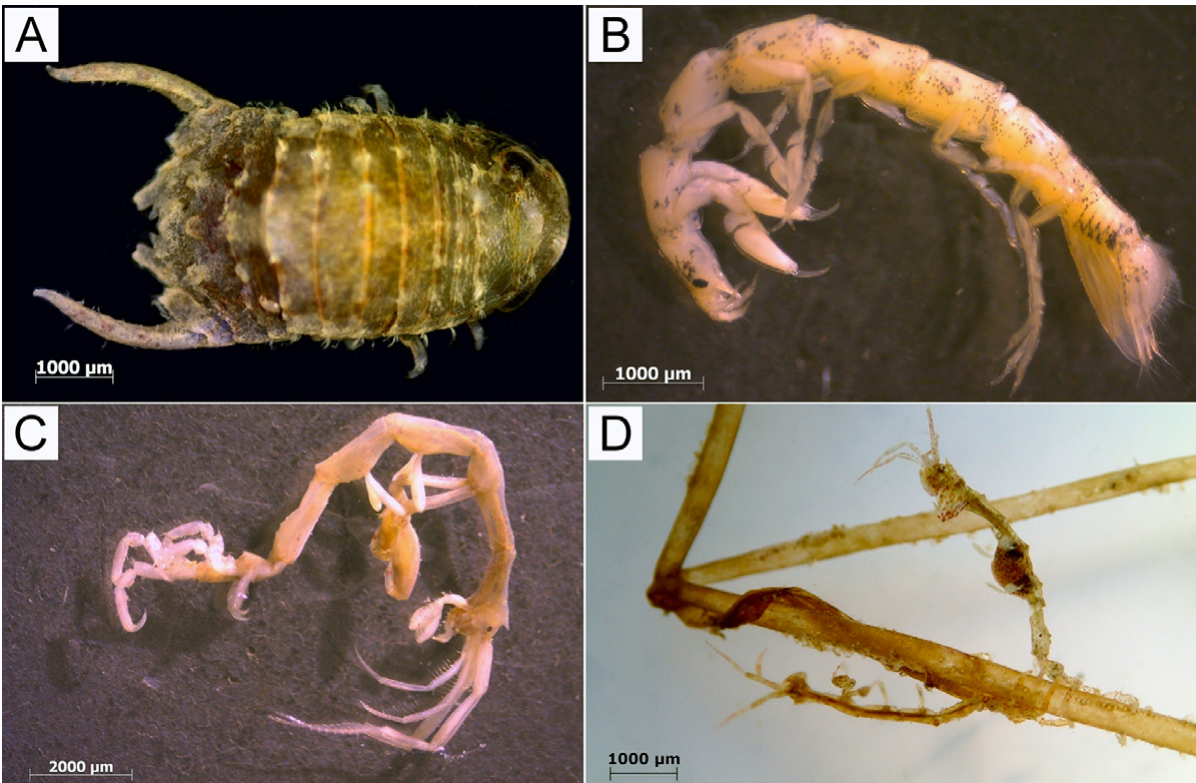
Fig. 4. – Non-indigenous peracarids associated with the spaghetti bryozoan in La Grande Motte: (A) Paracerceis sculpta ; (B) Paranthura japonica ; (C) Caprella scaura ; (D) C. scaura specimens attached to Amathia verticillata